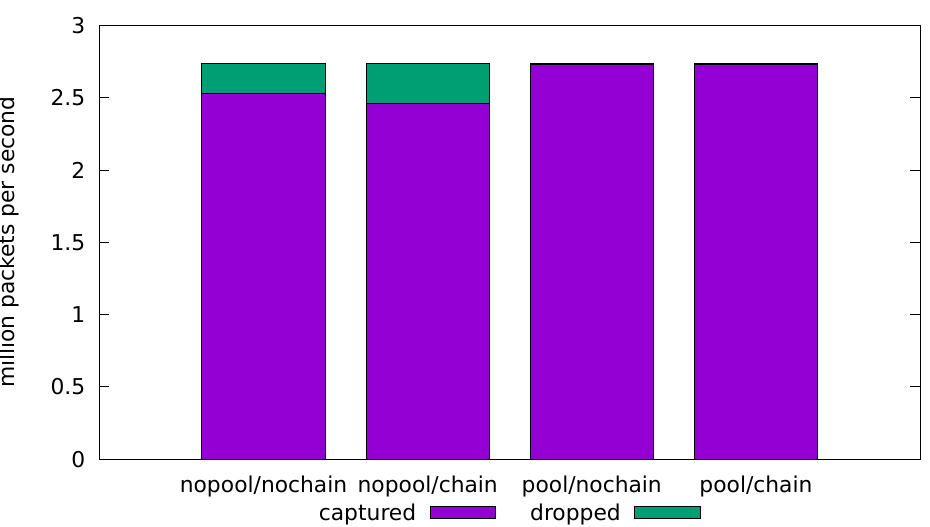
Figure 7. Evaluation on real-traffic replayed at 10 Gb/s from a pcap file. Application is run with all four operators in the processing pipeline.